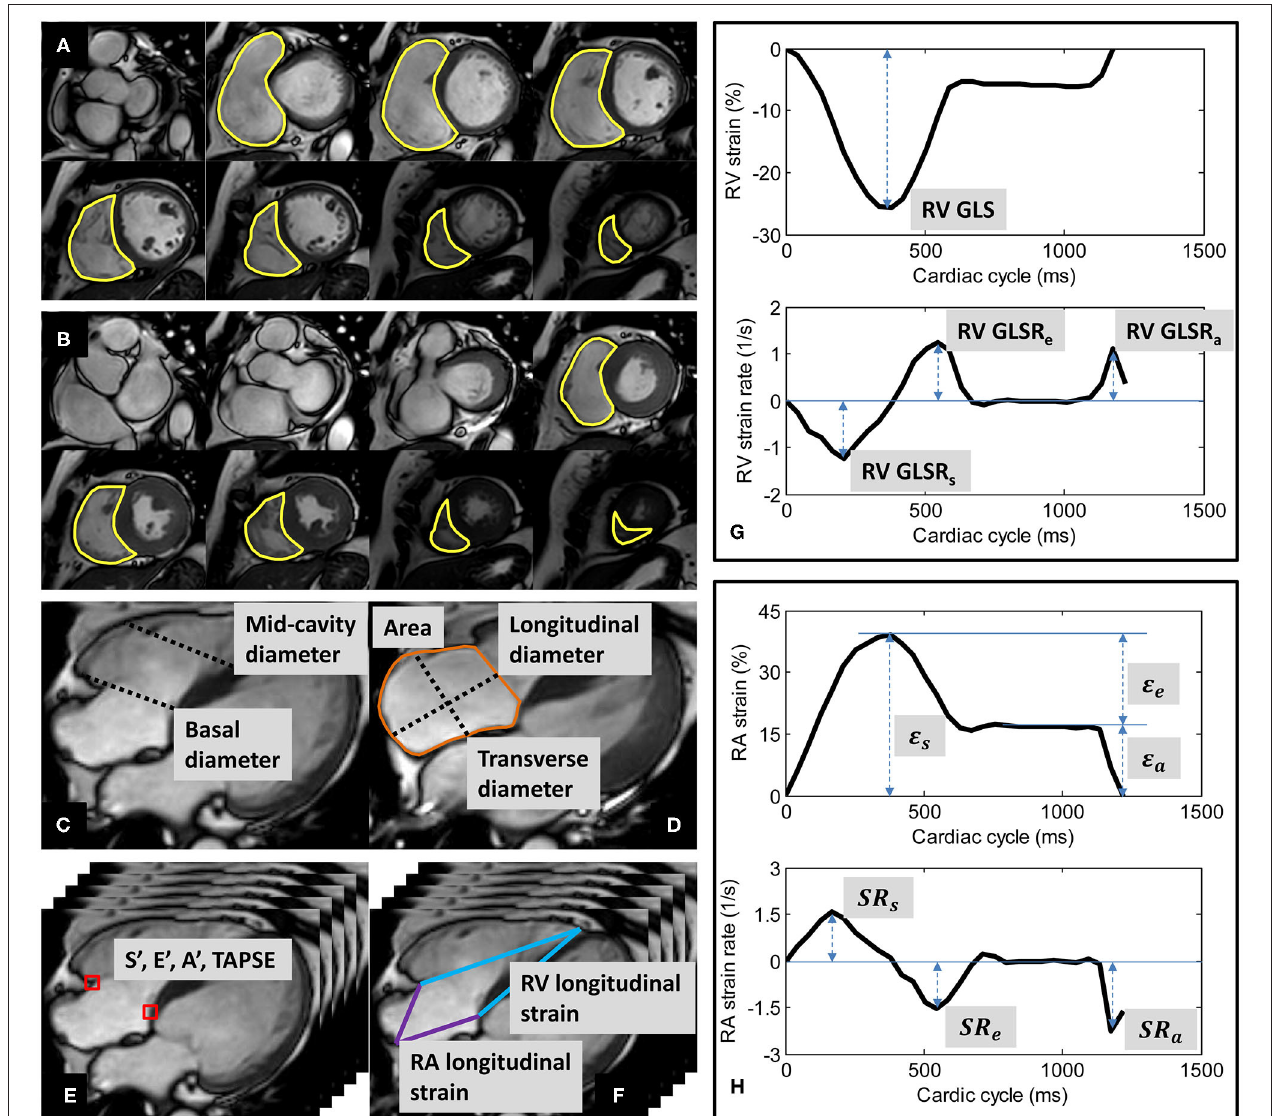
FIGURE 1 | Derivation of right ventricular (RV) volumes by contouring of RV at (A) end-diastole and (B) end-systole; (C) RV basal and mid-cavity diameters at end-diastole; (D) right atrial (RA) area, longitudinal and transverse diameters at RV end-systole; (E) tricuspid annular dynamics at RV medial (septum) and lateral (free wall); (F) longitudinal strains of RV and RA; (G) Example of RV strain and strain rate curves; (H) Example of RA strain and strain rate